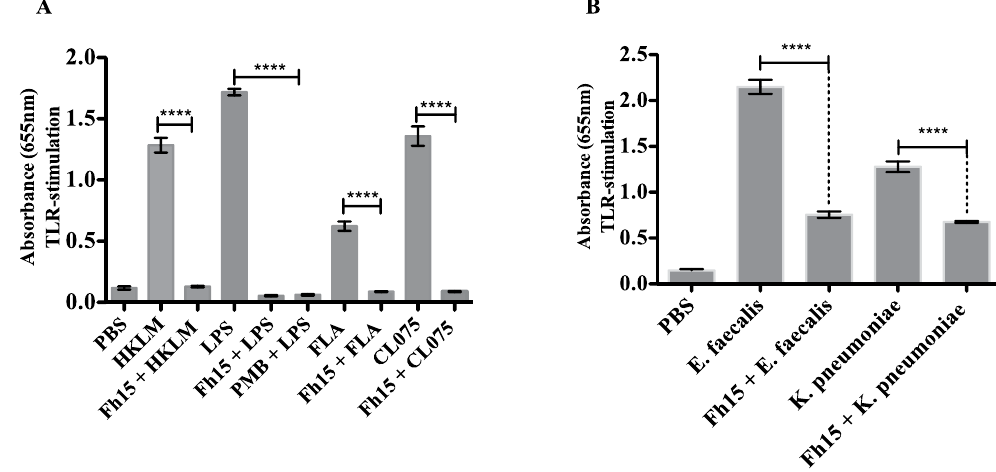
Figure 6. Fh15 suppresses the stimulation of multiple toll-like receptors. ( A ) THP1 Blue-CD14 cells were seeded at 1 × 10 5 cells/well in 96-well flat-bottom plates and cultured with Fh15 (10 μ g/ml) alone or 30 min prior to stimulation with optimized concentrations (established by the manufacturer) of heat killed Listeria monocytogenes (HKLM; 10 8 cells/ml), flagellin (FLA; 1 μ g/ml) or ortozialoquinoline (CL075; 10 μ g/ml). Control cells were stimulated with PBS or a single TLR-ligand. ( B ) Cells were cultured with Fh15 (10 μ g/ml) and then stimulated with whole extracts (1 × 10 8 cells/ml) of Enterococcus faecalis or Klebsiella pneumonia . Cells incubated only with each bacteria extract were used as activation control. Fh15 significantly suppressed